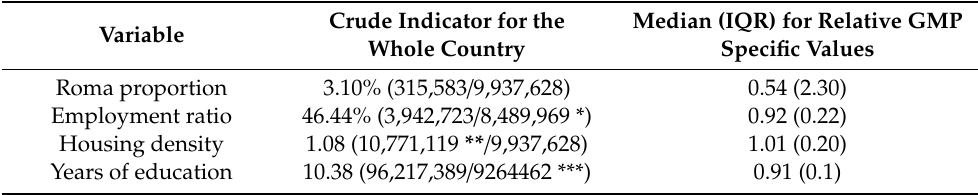
Table 1. Socioeconomic status indicators for the whole population and their distribution among general medical practices in Hungary.